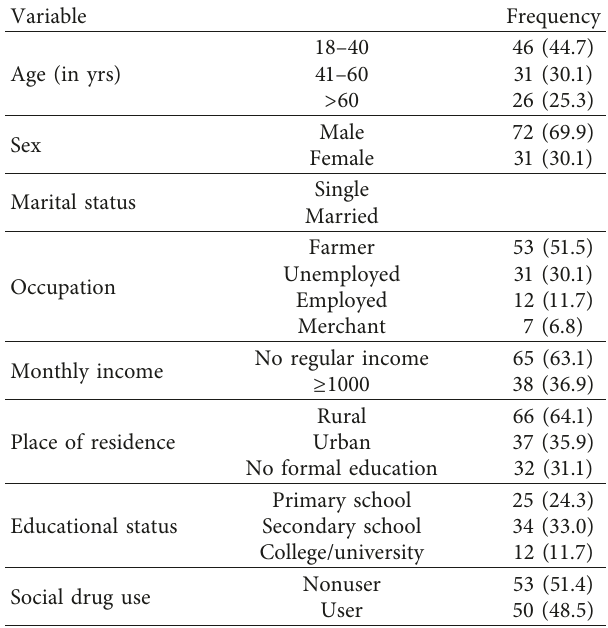
Table 1: Sociodemographic characteristics of CKD patients at JUMC, Jimma Zone, Jimma, Southwest Ethiopia, from April 01 to